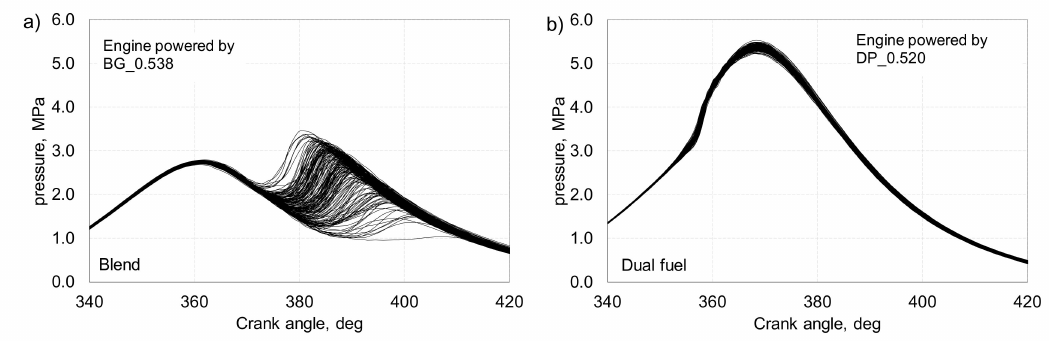
Figure 9. Cycle variation of engine powered by BG blend ( a ) and as DF engine ( b ).